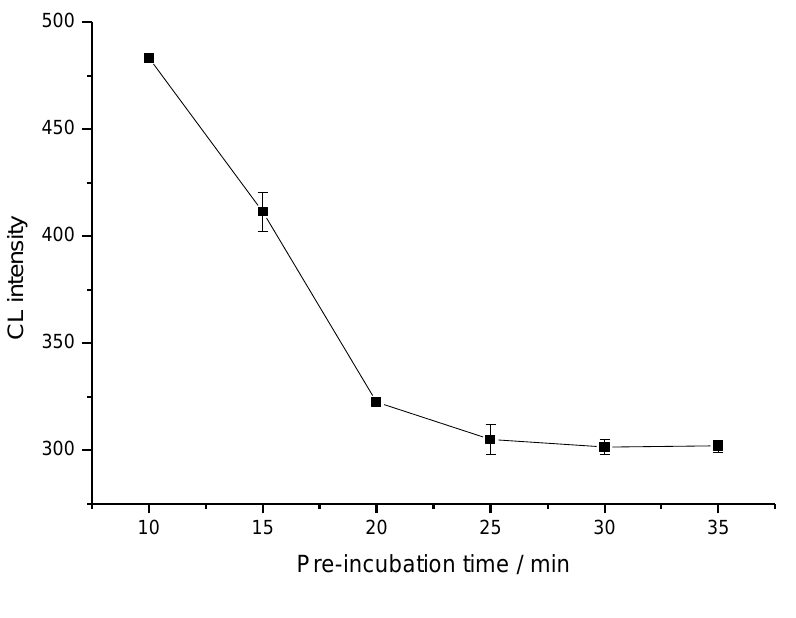
Figure 2. Effect of the pre-incubation time on CL intensity of 0 ng/mL CEA 1:9 mixed with enzyme